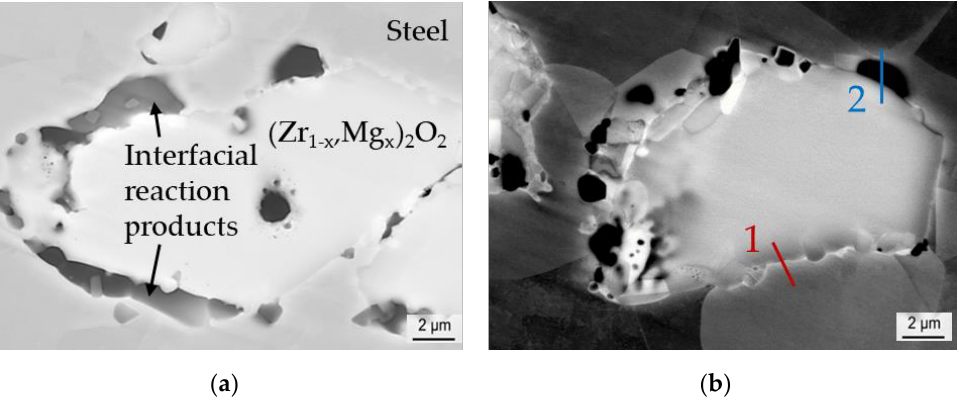
Figure 10. SEM images based on backscattered electrons: ( a ) zirconia particle with interfacial reaction products at the interface with steel matrix (magnification: 5000×) [39], ( b ) characteristic microstructure of composite (two EDS line scans across the interface are highlighted; magnification: 1500×).